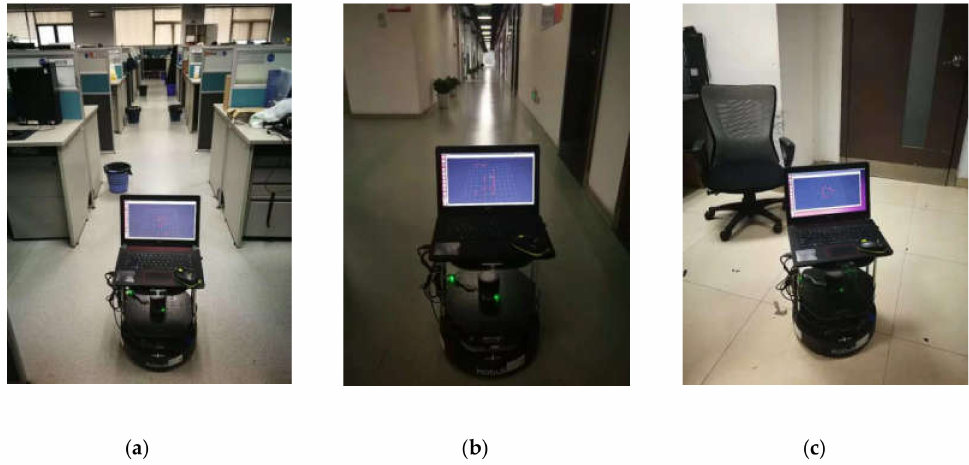
Figure 7. Typical experimental environments: Office ( a ); Corridor ( b ); and Room ( c